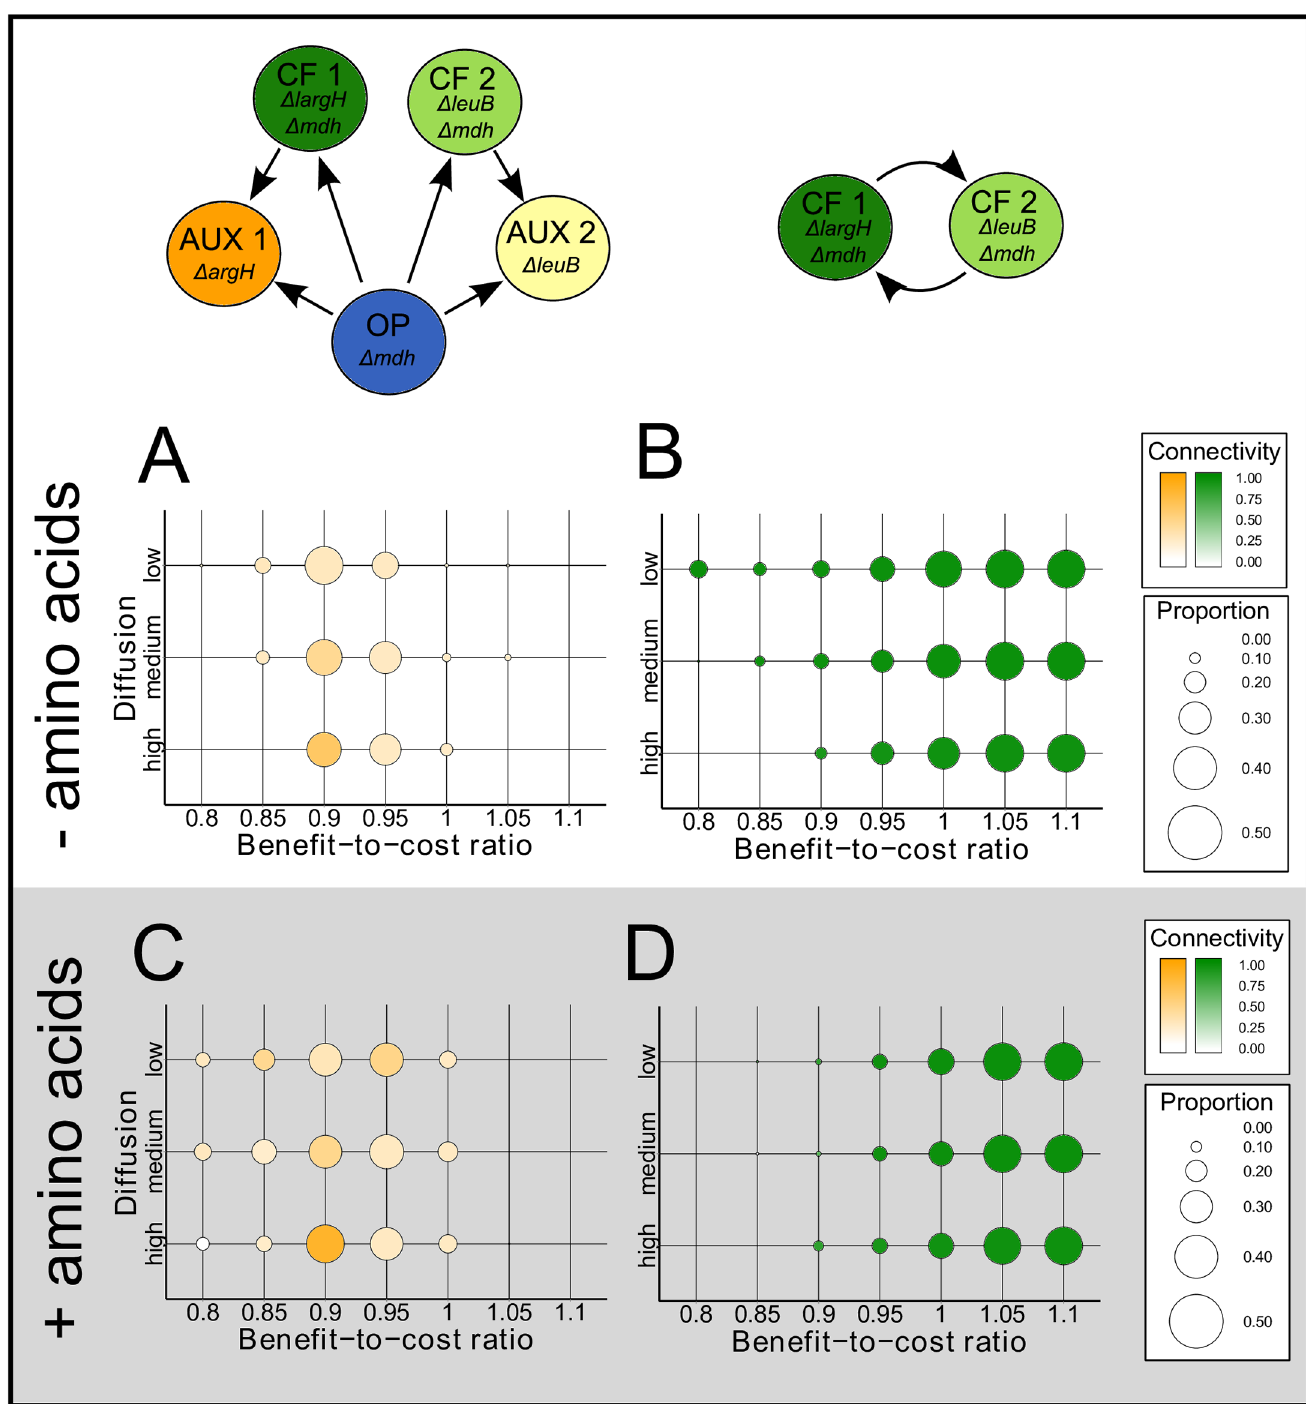
Fig 3. Prevalence of unilateral and bilateral cross-feeding. Sizes of circles represent the mean proportion of ( A, C ) unilateral and ( B, D ) bilateral cross-feeding that included all interactions depicted in the schematic above. Colors of circles represent the mean connectivity between cell types that measures the co-occurrence of genotypes and thus reflects the probability of genotypes to display one or the other type of cross-feeding. 100 simulation runs were analyzed per parameter combination. Simulation results with ( A, B ) no or ( B, D ) a substantial addition of amino acids to the environment are displayed. Parameter combinations that were analyzed in each panel include the benefit-to-cost ratio (x-axes) and the degree of metabolite diffusion in the environment (y-axes) ranging from low (structured environment) to high (unstructured environment).